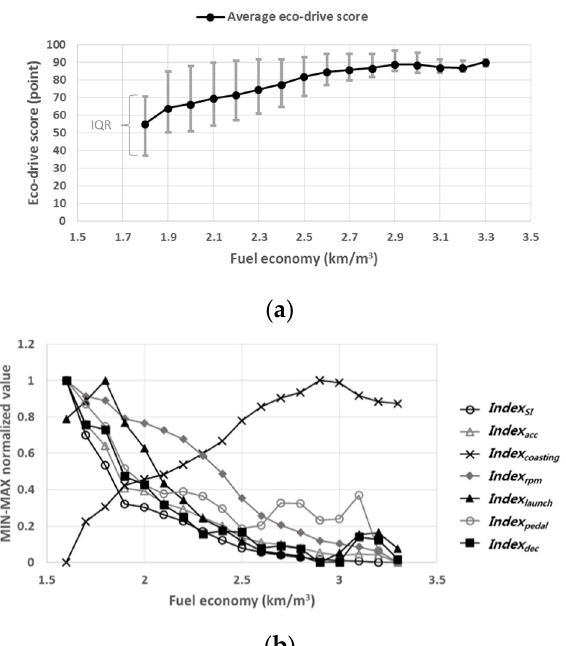
Figure 8. Tendency of score and indexes: ( a ) average eco-drive score according to fuel economy; ( b ) each monitoring item index normalization value according to fuel economy.